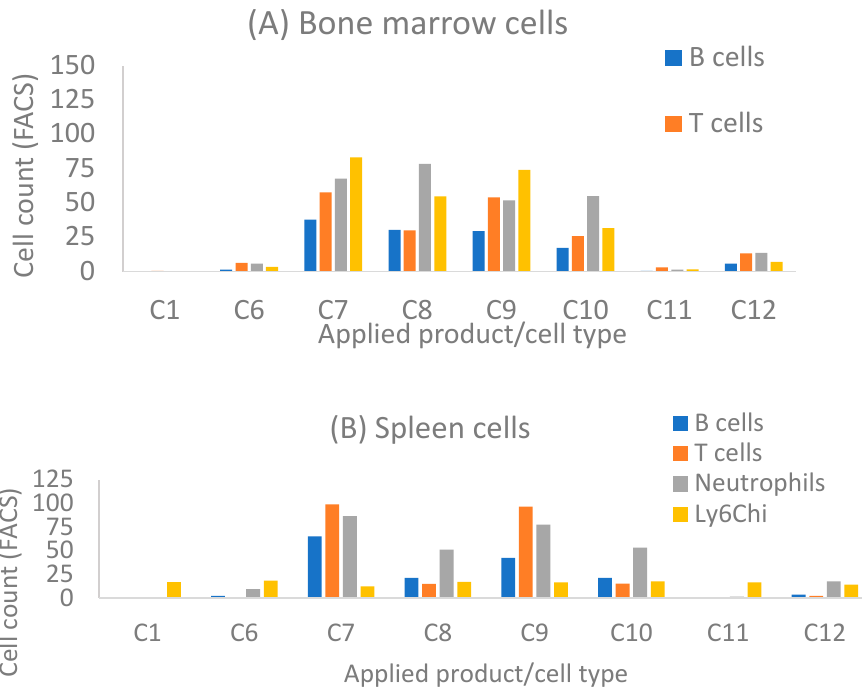
Figure 4. FACS results for nanotube products taken up by particular mouse immune cells in bone marrow (BM) ( A ), and spleen ( B ). BM and splenocytes were isolated from B6 mice and incubated with designated SWCNTs at 200 nM for 30 min. See details in Section 2. Applied products were as follows: Exchange (HiPco SWCNTs), 1. siNOTCH/MTX; 6. Not loaded nanotubes; Direct (carboxyl-SWCNTs), 7. siNOTCH/MTX, 8. siNOTCH, 9. siRNA/MTX, 10. siRNA, 11. MTX, 12. Not loaded nanotubes.